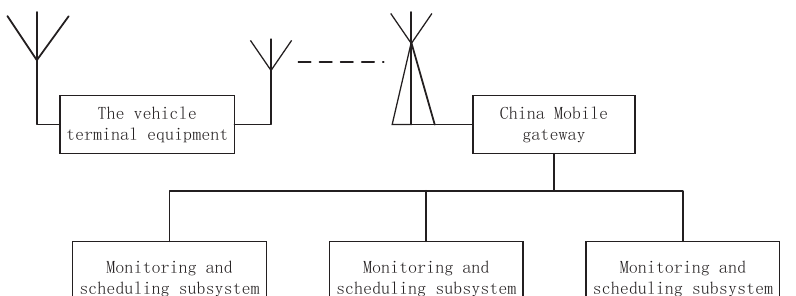
Figure 2 Principle of vehicle monitoring and